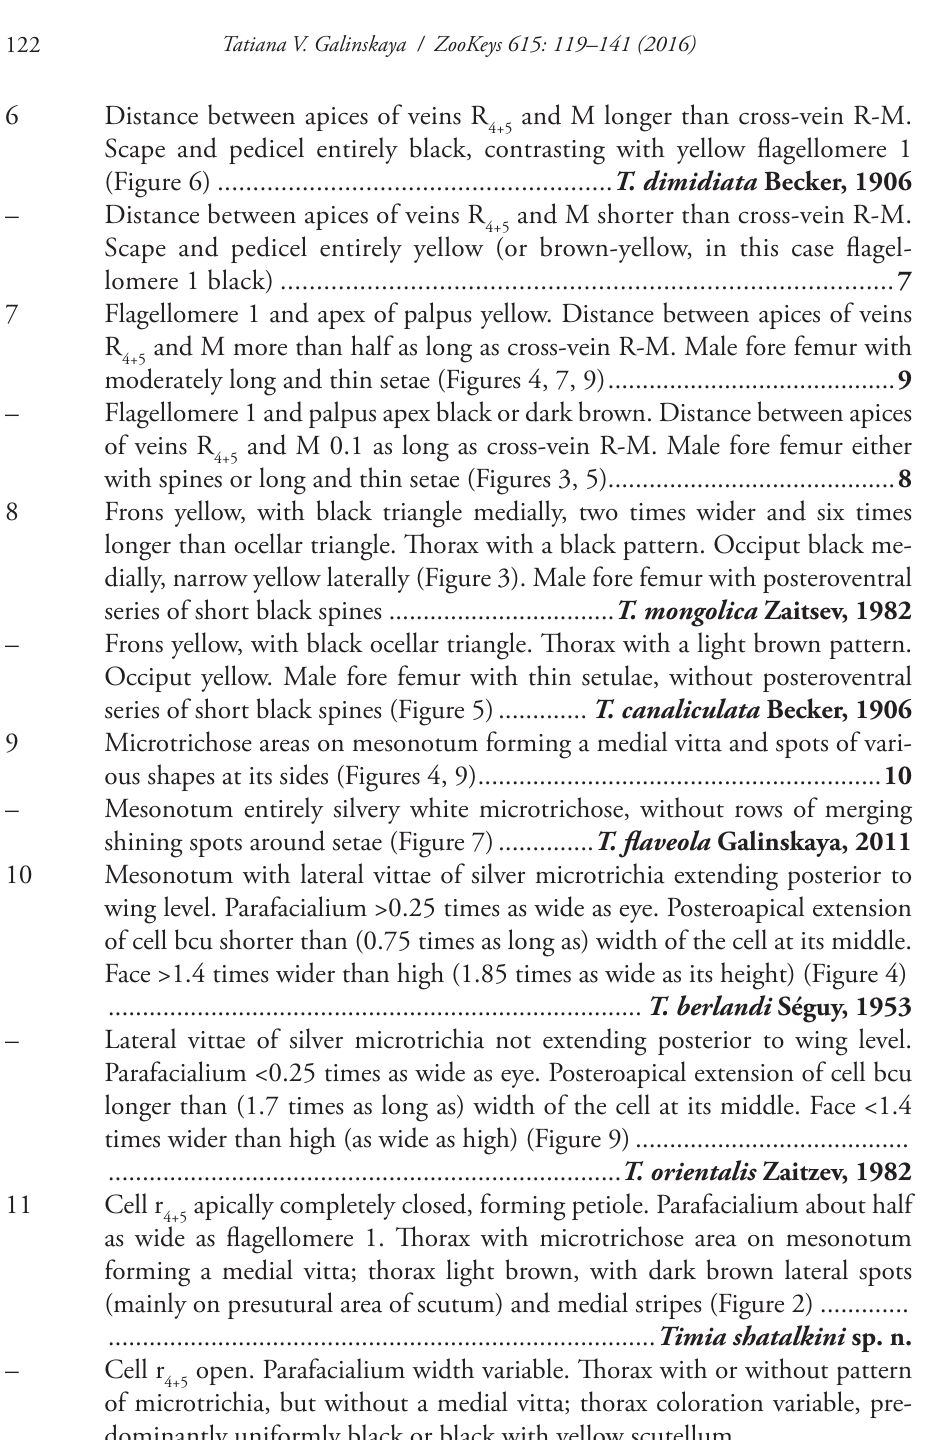
Distance between apices of veins R and M longer than cross-vein R-M. 4+5 Scape and pedicel entirely black, contrasting with yellow flagellomere 1 (Figure 6) ........................................................ T. dimidiata Becker, 1906 – Distance between apices of veins R and M shorter than cross-vein R-M. 4+5 Scape and pedicel entirely yellow (or brown-yellow, in this case flagel- 7 Flagellomere 1 and apex of palpus yellow. Distance between apices of veins R and M more than half as long as cross-vein R-M. Male fore femur with 4+5 moderately long and thin setae (Figures 4, 7, 9) .......................................... 9 – Flagellomere 1 and palpus apex black or dark brown. Distance between apices of veins R and M 0.1 as long as cross-vein R-M. Male fore femur either 4+5 with spines or long and thin setae (Figures 3, 5).......................................... 8 8 Frons yellow, with black triangle medially, two times wider and six times longer than ocellar triangle. Thorax with a black pattern. Occiput black me- dially, narrow yellow laterally (Figure 3). Male fore femur with posteroventral series of short black spines ................................. T. mongolica Zaitsev, 1982 – Frons yellow, with black ocellar triangle. Thorax with a light brown pattern. Occiput yellow. Male fore femur with thin setulae, without posteroventral series of short black spines (Figure 5) ............. T. canaliculata Becker, 1906 9 Microtrichose areas on mesonotum forming a medial vitta and spots of vari- ous shapes at its sides (Figures 4, 9) ........................................................... 10 – Mesonotum entirely silvery white microtrichose, without rows of merging shining spots around setae (Figure 7) .............. T. flaveola Galinskaya, 2011 10 Mesonotum with lateral vittae of silver microtrichia extending posterior to wing level. Parafacialium >0.25 times as wide as eye. Posteroapical extension of cell bcu shorter than (0.75 times as long as) width of the cell at its middle. Face >1.4 times wider than high (1.85 times as wide as its height) (Figure 4) – Lateral vittae of silver microtrichia not extending posterior to wing level. Parafacialium <0.25 times as wide as eye. Posteroapical extension of cell bcu longer than (1.7 times as long as) width of the cell at its middle. Face <1.4 times wider than high (as wide as high) (Figure 9) ........................................ 11 Cell r apically completely closed, forming petiole. Parafacialium about half 4+5 as wide as flagellomere 1. Thorax with microtrichose area on mesonotum forming a medial vitta; thorax light brown, with dark brown lateral spots (mainly on presutural area of scutum) and medial stripes (Figure 2) ............. – Cell r open. Parafacialium width variable. Thorax with or without pattern 4+5 of microtrichia, but without a medial vitta; thorax coloration variable, pre- dominantly uniformly black or black with yellow scutellum